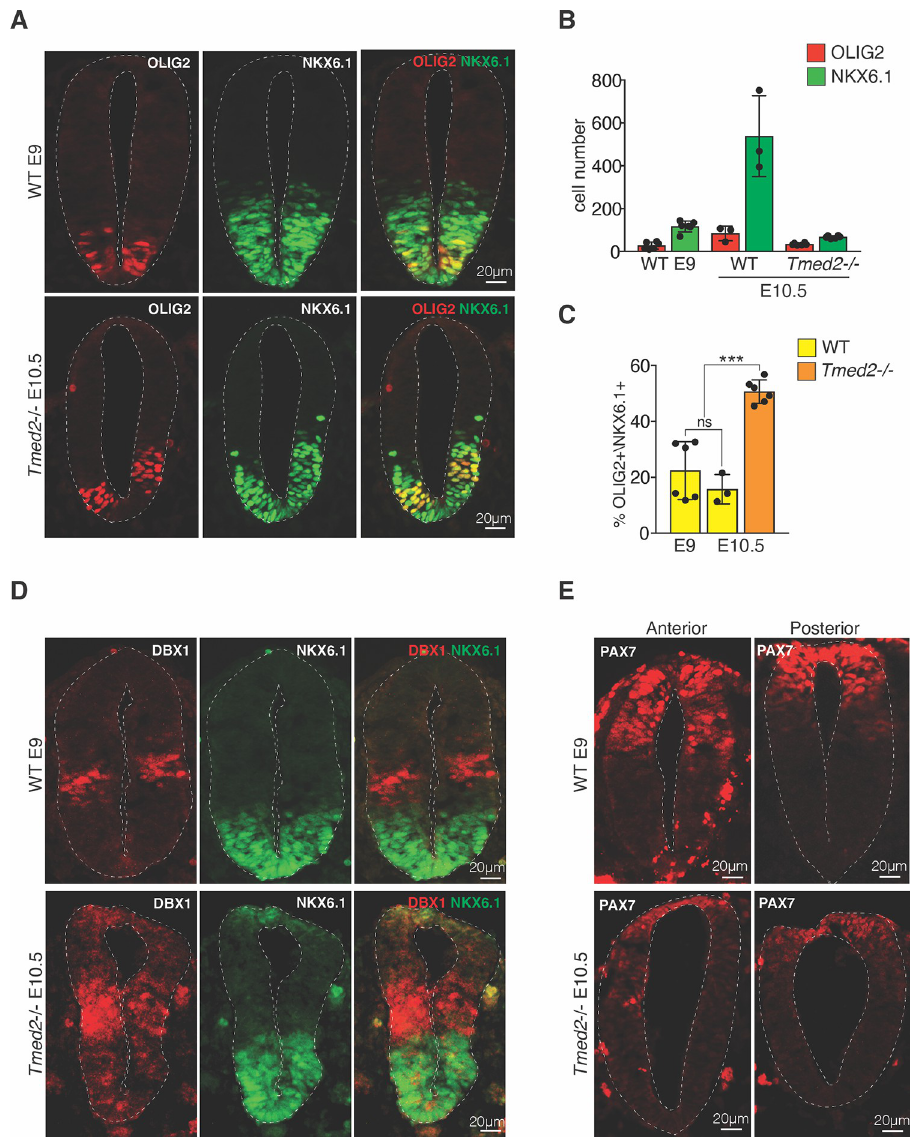
Fig 5. Mutation of Tmed2 affects neural tube pattering. (A–C) Mutation of Tmed2 increases expansion of the OLIG2 expression domain. (A) Neural tube sections of E9.0 control and E10.5 Tmed2 −/− embryos were stained for the ventral markers OLIG2 and NKX6.1. Scale bar = 20 μ m. (B) Quantification of OLIG2 and NKX6.1 expressing NPCs and (C) the percentage of NPCs expressing OLIG2 relative to NKX6.1 positive NPCs in neural tube section of E9.0 and E10.5 control, as well as E10.5 Tmed2 −/− embryos. Asterisks denote statistical significance for difference between indicated samples. (D) Mutation of Tmed2 promotes expansion of the DBX1 expression domain. Neural tube sections of E9.0 control and E10.5 Tmed2 −/− embryos were stained for the markers DBX1 and NKX6.1. Scale bar = 20 μ m. (E) Tmed2 −/− embryos show decreased PAX7 expression. Neural tube sections derived from E9.0 control, and E10.5 Tmed2 −/− embryos were stained for the dorsal marker PAX7. Scale bar = 20 μ m. Anterior and posterior sections of the neural tube are shown for E9.0 contro, and E10.5 Tmed2 −/− embryos. The data underlying all the graphs shown in the figure are included in the S1 Data file. NPC, neural progenitor cell; WT, wild-type.